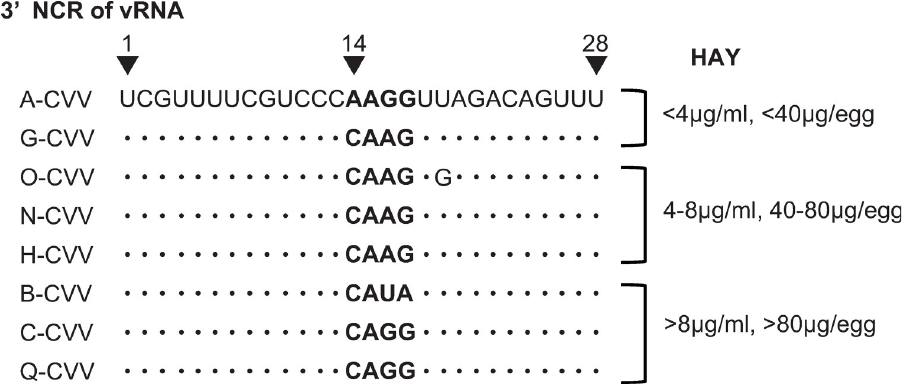
Fig 3. Nucleotide sequences of the 3’NCRs of HA vRNAs. Nucleotide sequences of the 3’ ends (1–28) of the HA vRNAs (negative sense) of each CVV. The nucleotide numbering starts from the 1 st nucleotide of the 3’NCR. The approximate HA yield (HAY) of each CVV is shown as μ g per ml of allantoic fluid and μ g per egg according to the values shown in S4 Table.